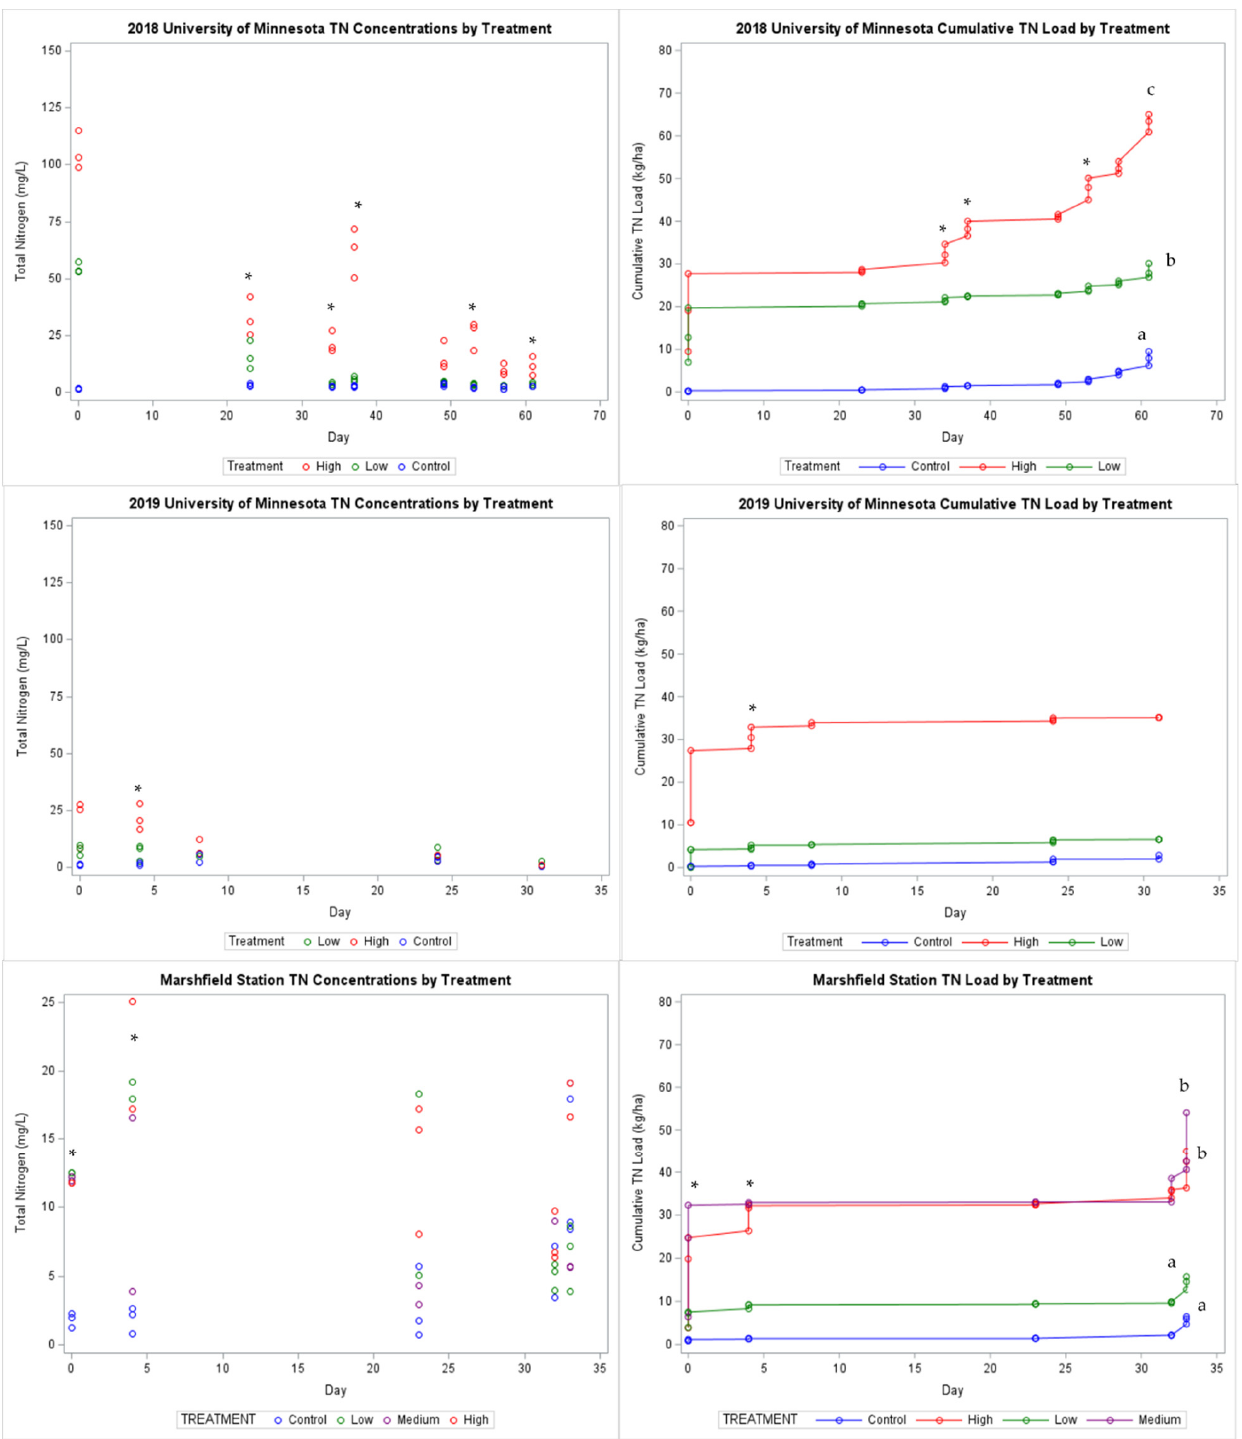
Figure 7. Snowmelt runoff total nitrogen (TN) concentrations and loads by treatment for each site and year of the experiment. Asterisks indicate a significant ( p ≤ 0.05) main effect of manure solids content. Cumulative loads without a common lower case letter differ ( p ≤